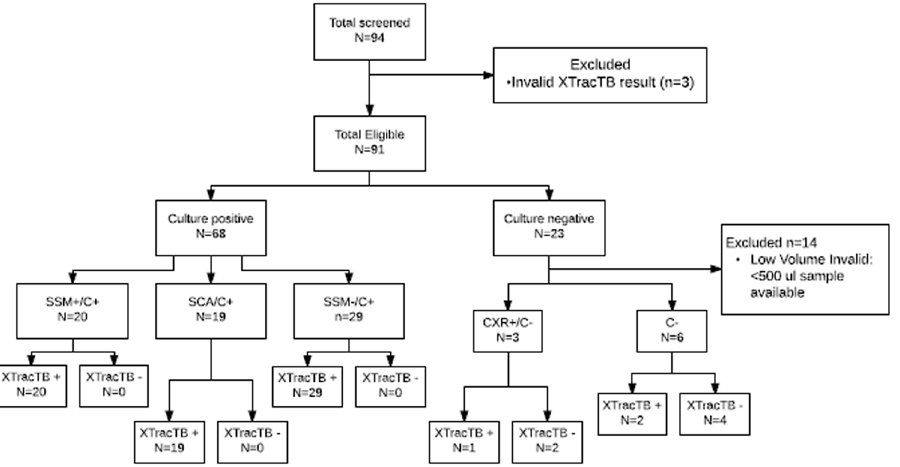
Figure 3. Schematic of study one protocol for sample testing. SSM − = concentrated sputum smear microscopy negative; SSM + = concentrated sputum smear microscopy positive; C + = culture positive; C − = culture negative; CXR + = chest X-ray